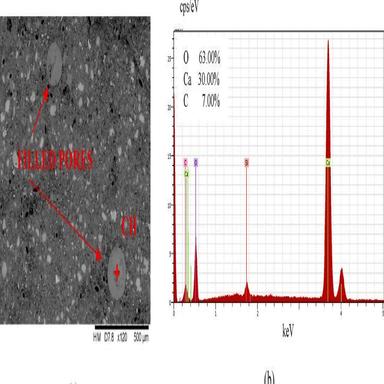
Bulk matrix with 2% CA: (a) SEM micrograph (BSE image) of a typical polished section, showing pores filled with CH; (b) EDS microanalysis (spectrum and quantification of elements above 1%) of the CH grain pointed out by the red cross. (For interpretation of the references to colour in this figure legend, the reader is referred to the Web version of this article.)